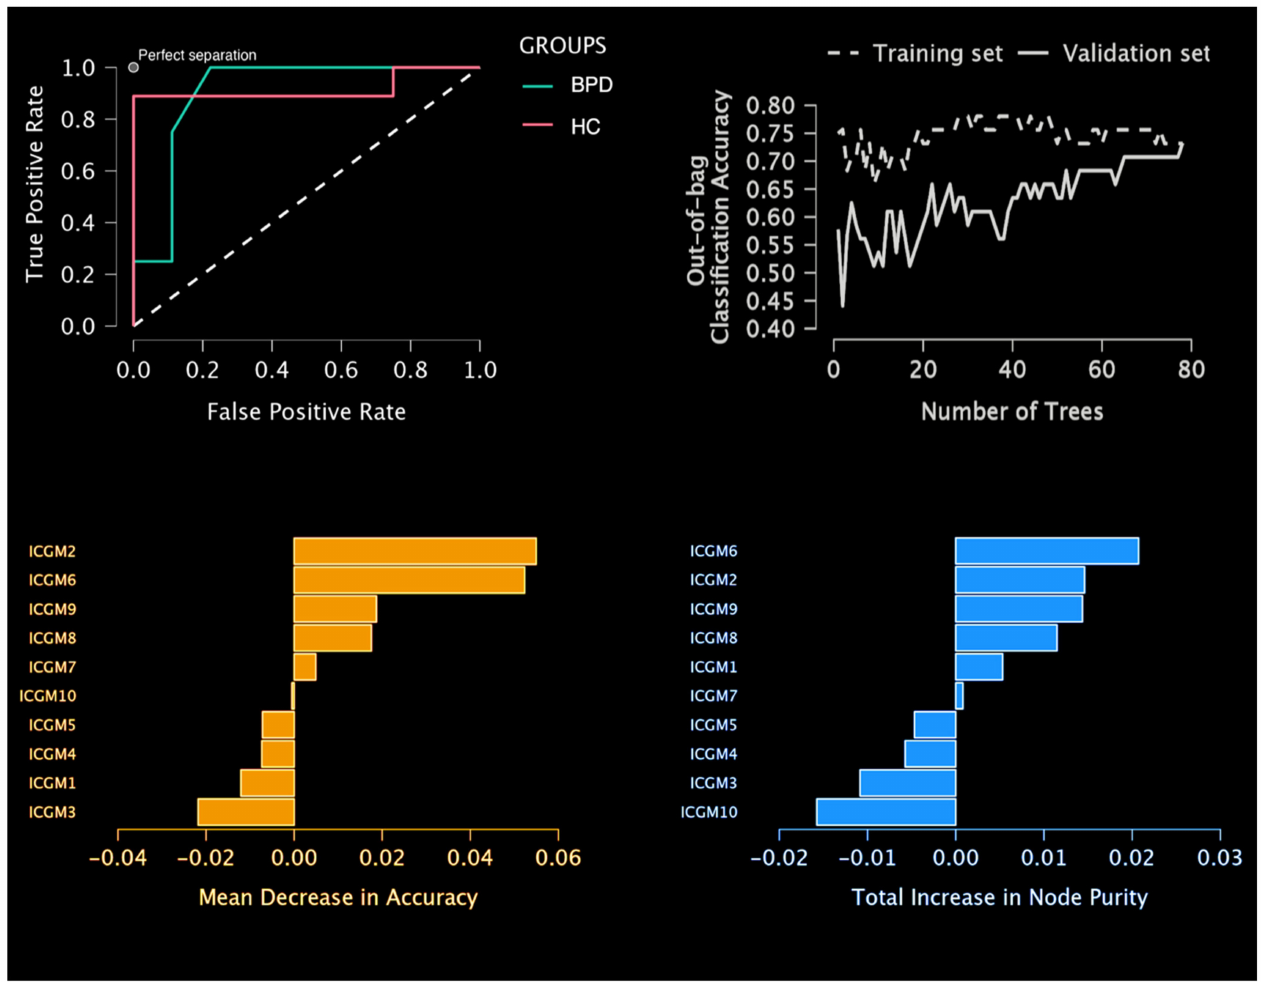
Figure 4. Prediction of new cases . Random forest classification performance